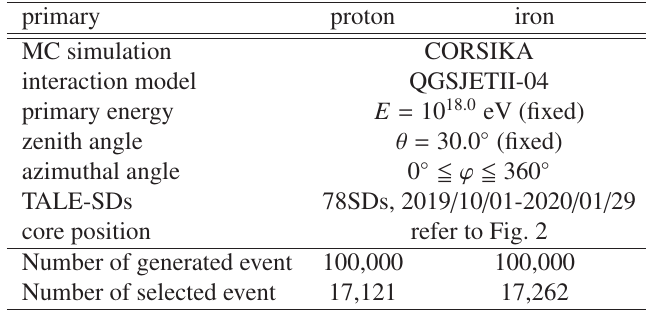
Table 1: MC simulation